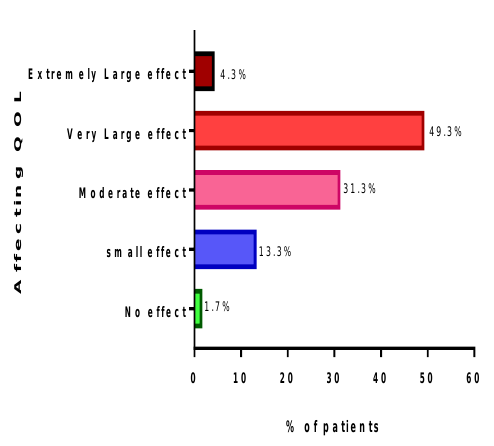
Figure 2. Effects of the disease severity on patient quality of life The total scores with their sub-scores of patient’s DLQI are shown in Table 4. Since the average of total DLQI scores was more than 10 (11.2±5.49), that indicates that the patient's QOL is being seriously impacted by their skin disease.